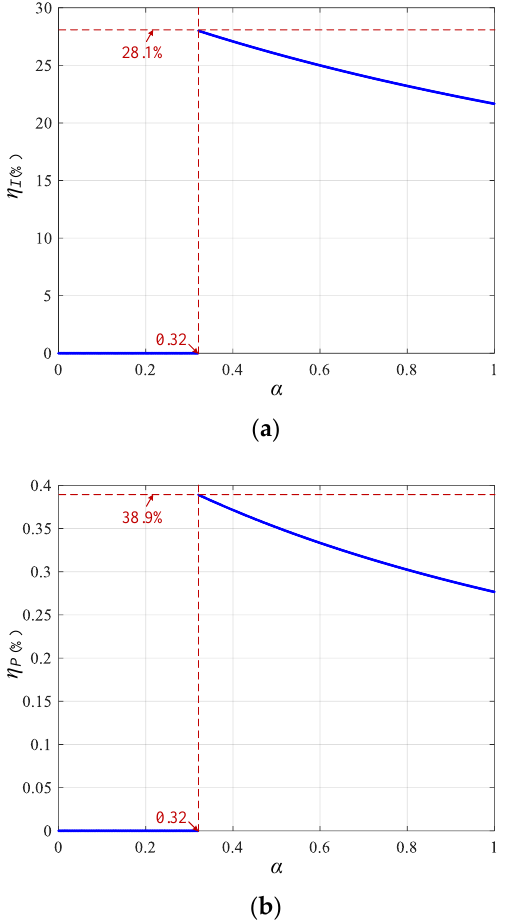
Figure 5. Values of η I and η P with the variation of α : ( a ) η I ; ( b ) η P .